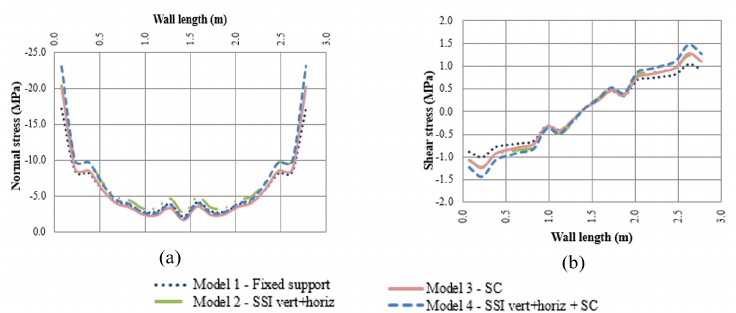
Figure 9. Distribution of stresses at the base of wall 41: (a) Normal stresses; (b) Shear stresses.